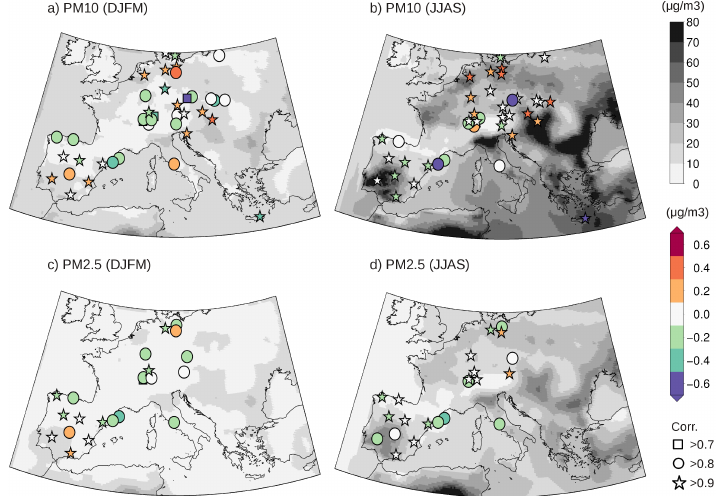
Fig. 1. Evaluation of the MM5–CHIMERE air quality modeling system described in Sect. 2.1. Gray shaded colors depict the simulated climatologies in µgm − 3 of PM 10 (up) and PM 2 . 5 (bottom) in winter (DJFM averages, left) and summer (JJAS averages, right). The com- parison of the simulated series with EMEP observations is provided by symbols: their color shows the difference in the standard deviation of the series between the simulation and the observations (in µgm − 3 ) , and their shape informs on the magnitude of the temporal correlation between the simulated and the observed